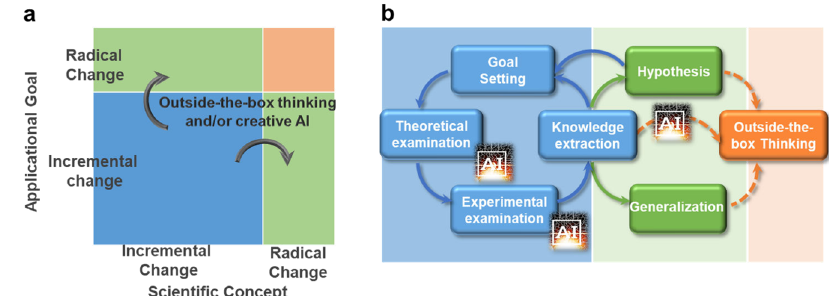
Fig. 3 Use of outside-the-box thinking in advancing scienti fi c research with ML. a Conceptual research domain de fi ned by a scienti fi c concept and an applicational goal where the arrows represent a radical shift in research driven by outside-the-box thinking and/or creative arti fi cial intelligence (AI). b Machine-learning-involved research loop in conjunction with possible generalization and outside-the-box thinking pathways. Blue arrows illustrate research fl ows in an incremental domain, green arrows show knowledge-based new research steps, and orange arrows illustrate radical shifts based on new hypotheses and generalizations in